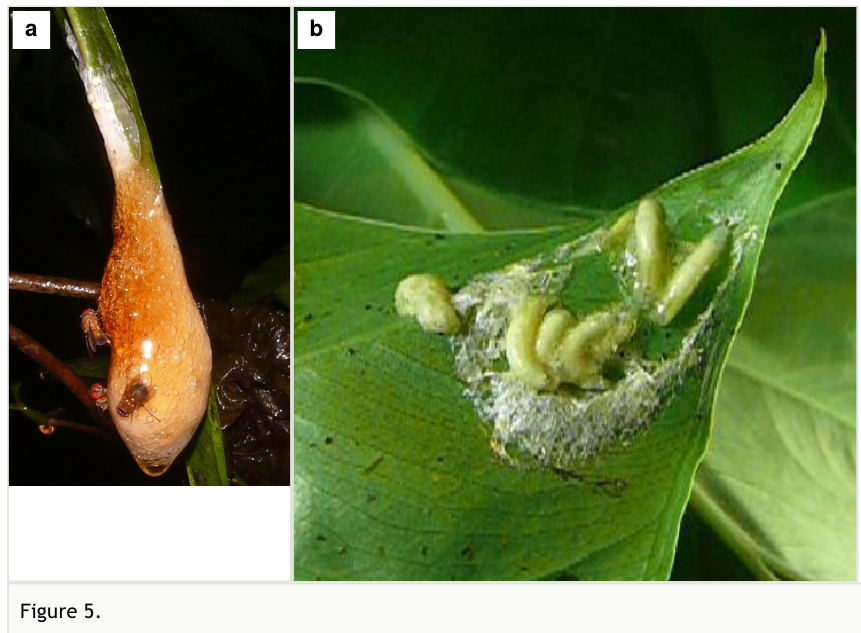
Figure 5. Caiusa adults and larvae on Chiromantis simus (Annandale) foam nests at Shyamkhola More (West Bengal, India). a : Three Caiusa females on the surface of a nest. The upper left female seems to be